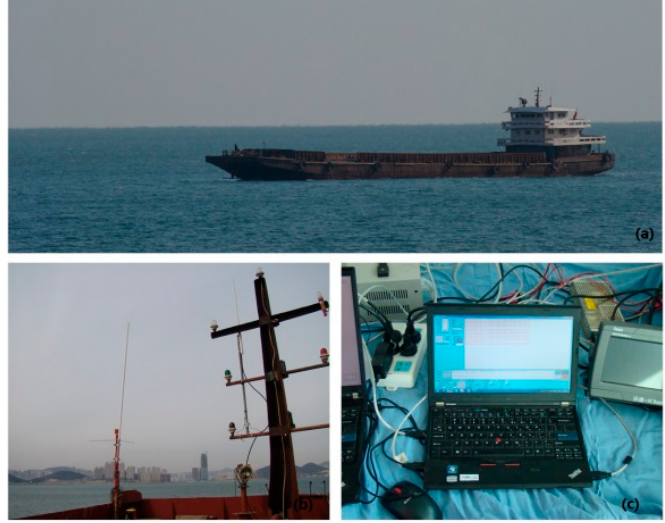
Figure 17. Positioning experiment scenario ( a ) The vessel for the positioning experiment; ( b ) The receiving antenna; ( c ) The received data display.